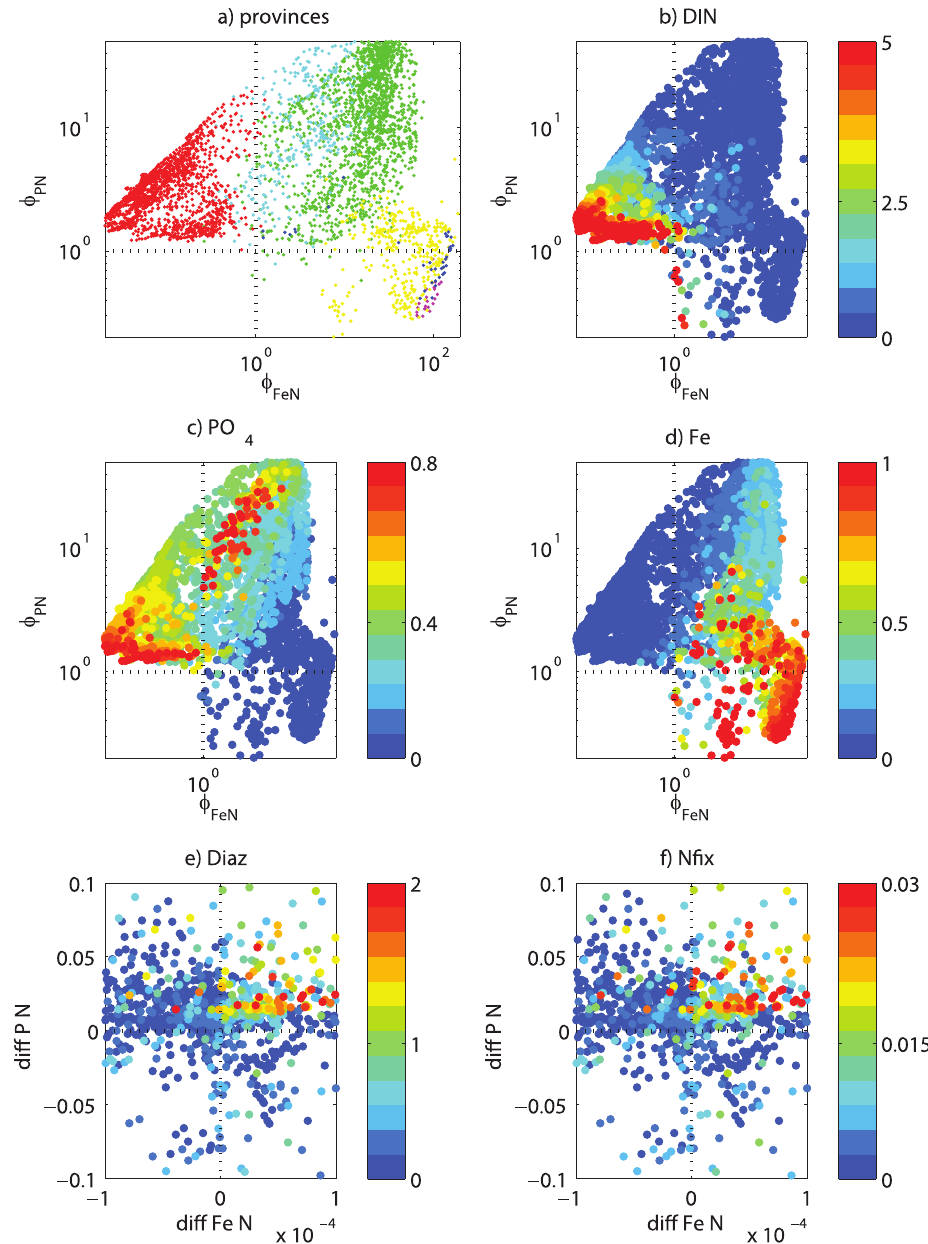
Figure 6. Scatter plots for pre-industrial conditions (experiment Control ). Each model grid cell is plotted as function of its annual averaged (a–d) supply rate ratio φ FeN and φ PN or (e,f) excess Fe, P supply rate ((I Fe − O Fe ) − R NFe (a) Province designation in same colors as in Figure 3 (except for VI which is colored magenta here); (b) concentration of DIN in the top 100m ( µM ); (c) phosphate ( µM ); (d) iron (nM); (e) diazotroph biomass (loggCm − 3 ); and (f) nitrogen fixation rate (loggNm − 2 yr − 1 ). Dotted lines indicate φ FeN = 1 and φ PN = 1 in (a-d) and ((I Fe − O Fe ) − R NFe (e,f)